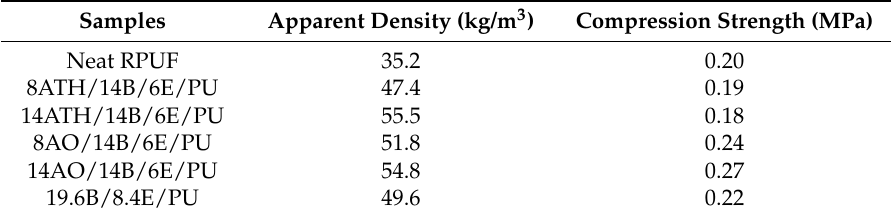
Table 4. Apparent density and compression strength of